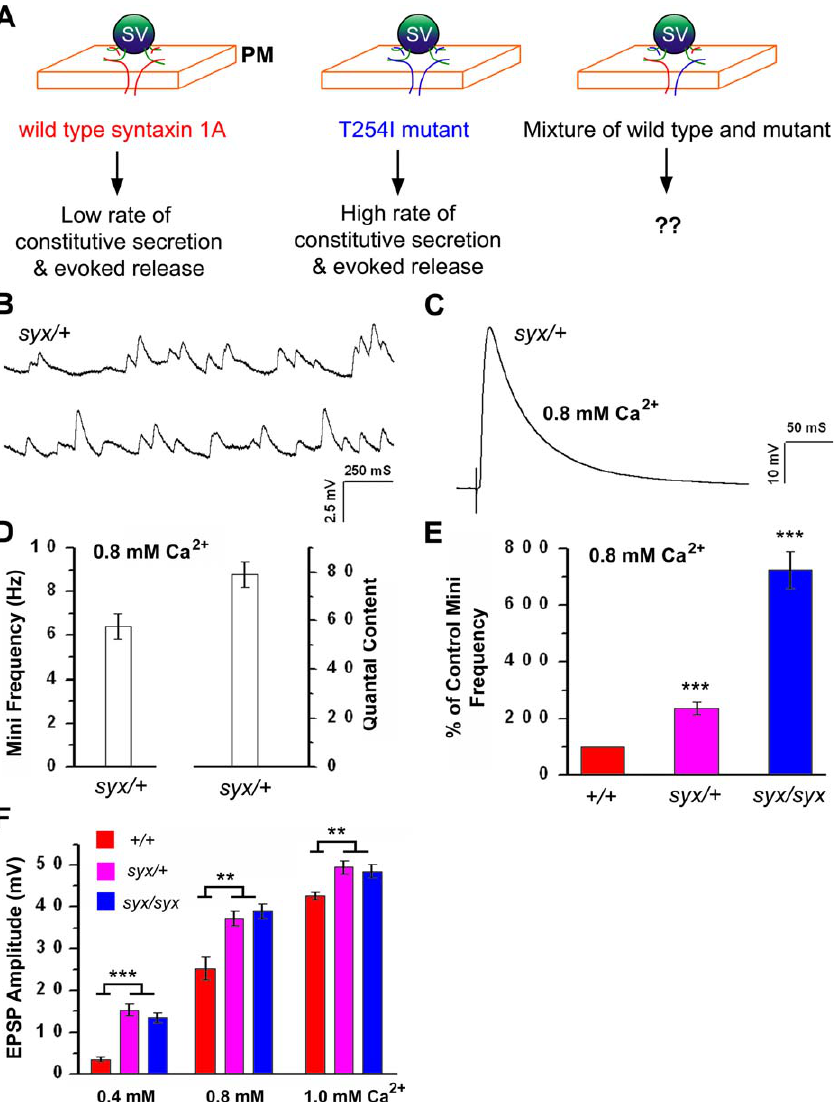
(A) Models of multimeric SNARE complexes found in the wild type ( þ / þ ), the homozygous syx 3–69 mutant (syx/syx), and the heterozygous syx 3–69 mutant ( syx/ þ ). Oligomerization of a mixture of the wild-type and the mutant SNARE complex predicts that the T254I mutant syntaxin 1A has dominant positive effects on vesicle fusion. The wild-type syntaxin 1A is illustrated in red, whereas the T254I mutant syntaxin 1A is in blue. For simplicity, SNAP-25 is omitted from these models. PM, plasma membrane; SV, synaptic vesicle. (B–D) Representative traces of minis and evoked EPSPs in the heterozygous larvae are shown in (B) and (C), respectively. The average mini frequency and quantal content are shown in (D). (E) The histogram shows that the normalized mini frequency in the heterozygote is significantly higher than that in the wild type, but much lower than that in the homozygous mutant. ***, p , 0.001. (F) A histogram of the average EPSP amplitude recorded from the wild type ( þ / þ ), the heterozygote ( syx/ þ ), and the homozygote (syx/syx) at three different Ca 2 þ concentrations: 0.4 mM, 0.8 mM, and 1 mM. At these Ca 2 þ concentrations, the amplitude of EPSPs in the wild type is consistently